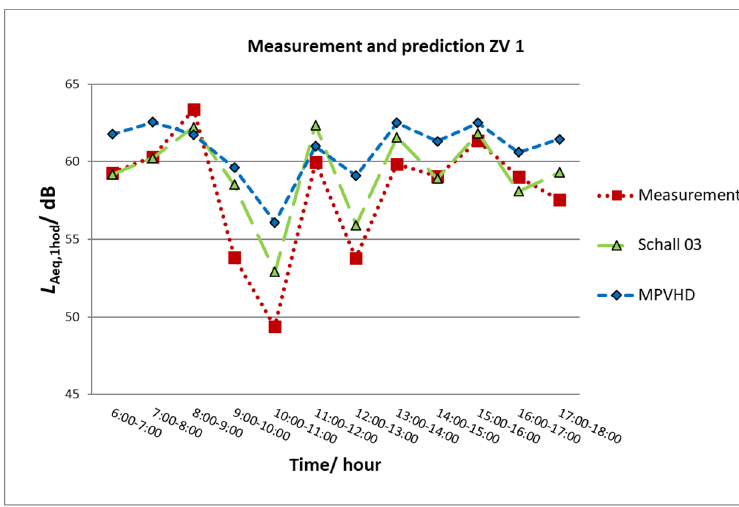
Figure 4. Graphical comparisons of the prediction and measurement of ZV1.